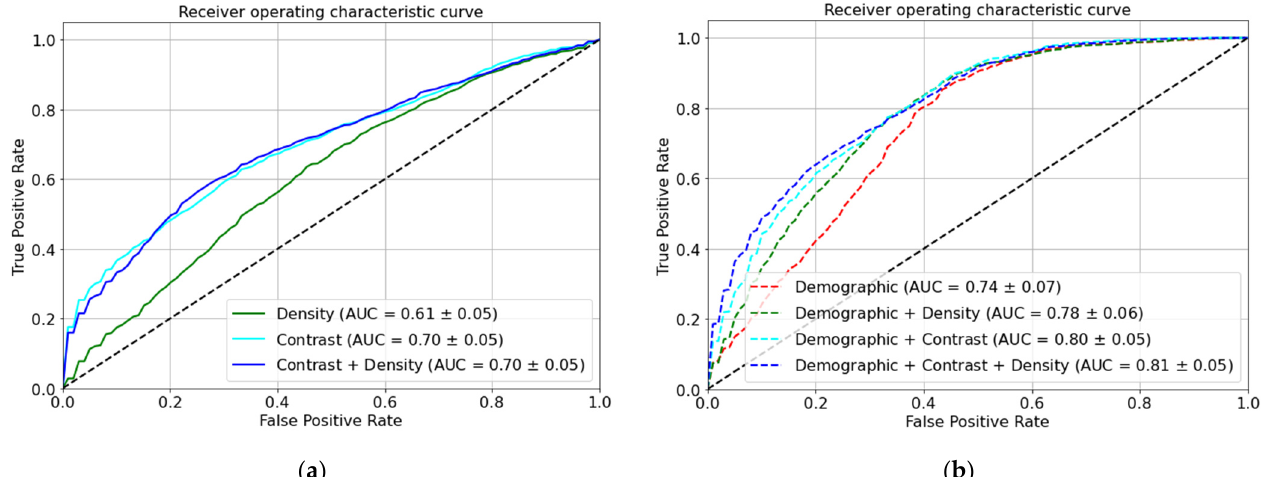
Figure 6. Malignant vs. benign ROC and AUC ( a ) without and ( b ) with demographic and clinical information (age, race, past medical history of breast cancer, menopausal status, and breast density). Inclusion of demographic and clinical data achieved a significantly higher AUC-ROC than imaging features alone. The black dotted line corresponds to the chance accuracy (AUC = 0.5)